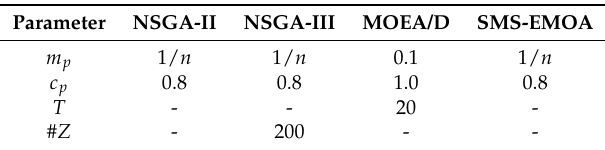
Table 1. Parameter configuration for each algorithm. Mutation probability m p , crossover probability c p , neighborhood size T , and number of reference points # Z